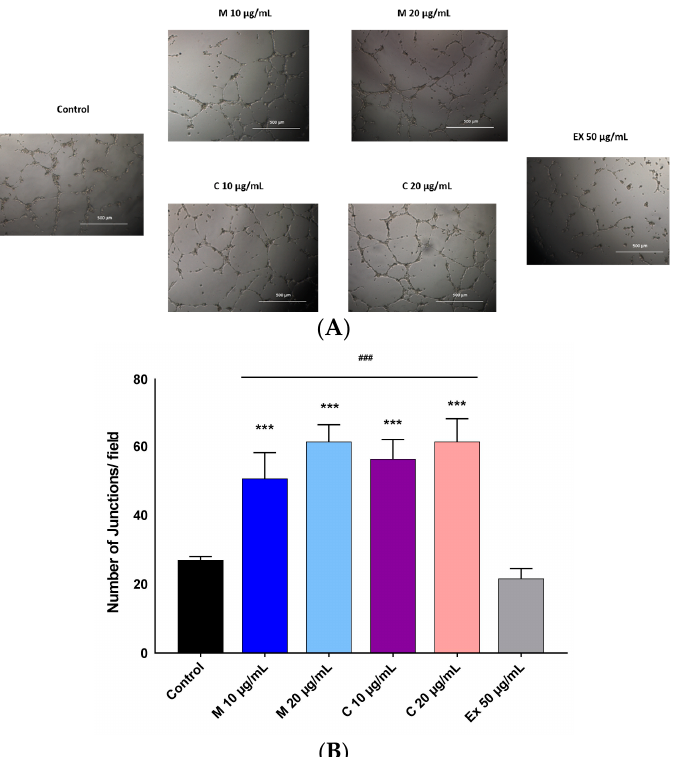
Figure 5. In vitro capillary tube formation of HUVECs treated in the absence or presence of myricetin-3- O - β -rhamnoside (M), chlorogenic acid (C), or the total extract (EX) of P. persica. ( A ) Phase contrast microscopy of the vascular network; ( B ) The number of junctions after 8 h of treatment. Tubular network formation was significantly higher for both the myricetin-3- O - β -rhamnoside (M) and chlorogenic acid compounds compared to the control (non-treated cells in growth media) and extract. Multiple t -tests were performed using Graph-Pad Prism 7.03 to determine the significance between each experimental group and control (*** p ≤ 0.001). T -tests were performed to compare each pure compound group to extract ( ### p ≤ 0.001).